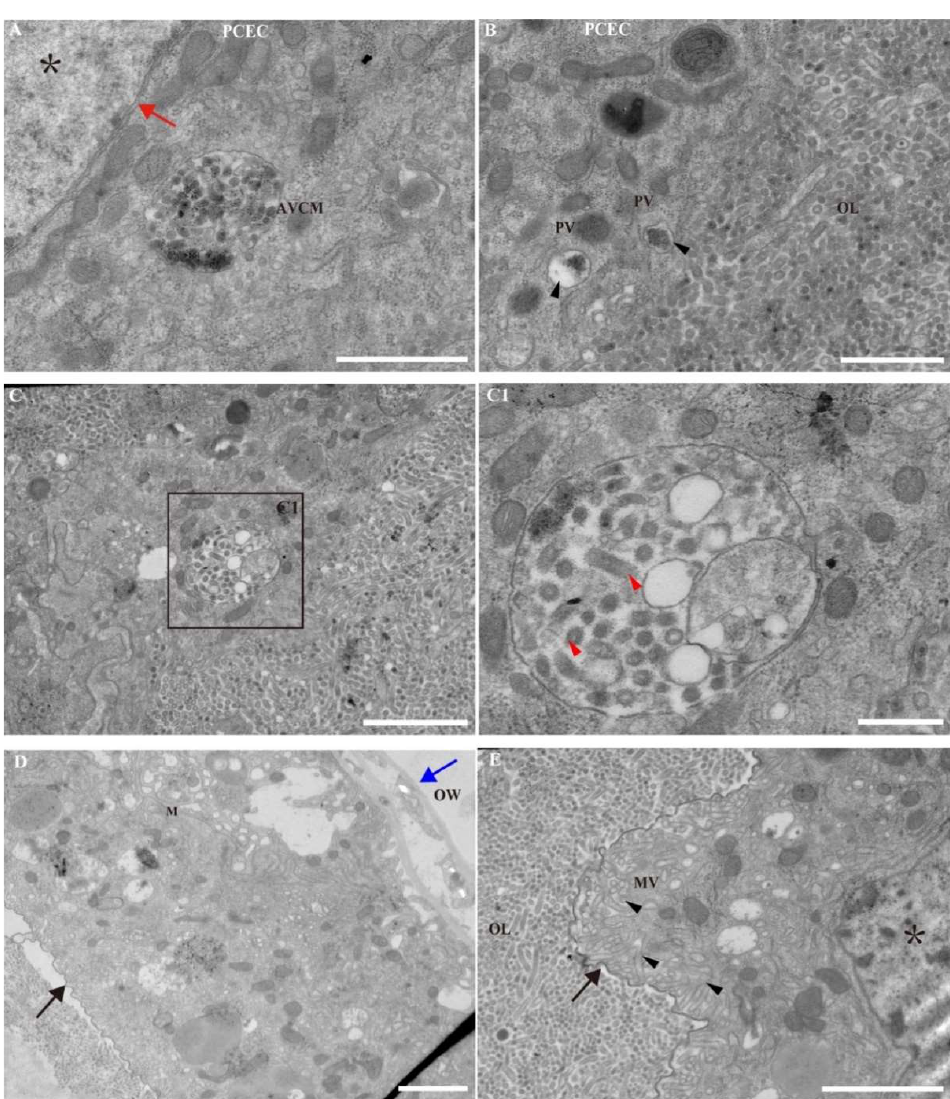
Figure 3. Phagocytic calyx epithelial cells (PCECs) clear non-enveloped nucleocapsids. ( A ) PCEC nucleus and autophagic vacuole containing MbBV (AVCM). Black asterisk: nucleus of PCECs. Red arrow: nuclear membrane. Scale bar in A, 1 µm. ( B ) Phagocytic vacuole (PV) and ovary lumen (OL). Scale bar in B, 1 µm. ( C ) AVCM and OL. Scale bar in C, 2 µm; ( C1 ) Non-enveloped nucleocapsid in AVCM. Scale bar in C1, 500 nm. ( D ) Non-phagocytic ovary epithelial cells with a cuticular line and ovary wall (OW). Black arrow: cuticular lining; blue arrow: OW; Scale bar in D, 2 µm. ( E ) Non-phagocytic ovary epithelial cells microvilli and OL; black arrow: cuticular line; black asterisk: nucleus of non-phagocytic ovary epithelial cells; OL: ovary lumen; MV: microvilli; scale bar in E, 2 µm.